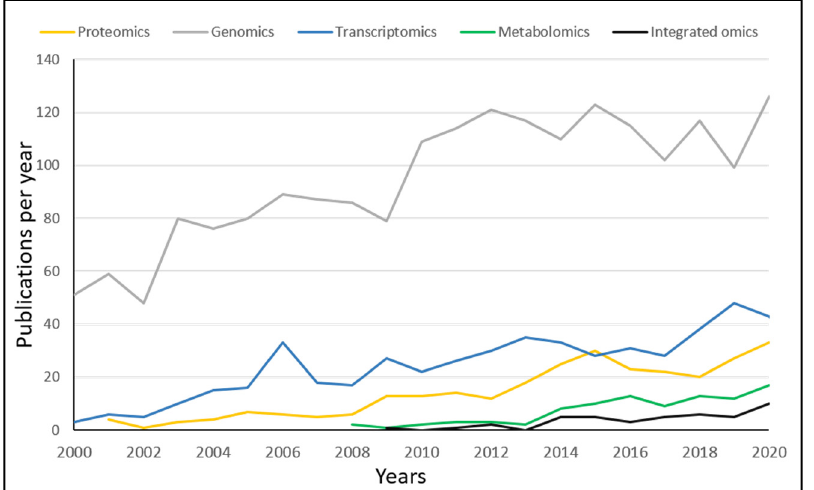
Figure 3. Publications for radiation biology per year between 2000–2020 retrieved from the NCBI Pubmed database. The search terms for different omics platforms used in radiation biology were applied and all forms of publications, including reviews, are included in the